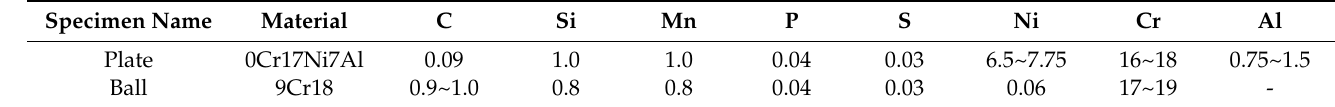
Table 7. Chemical composition and mass fraction of friction pair.